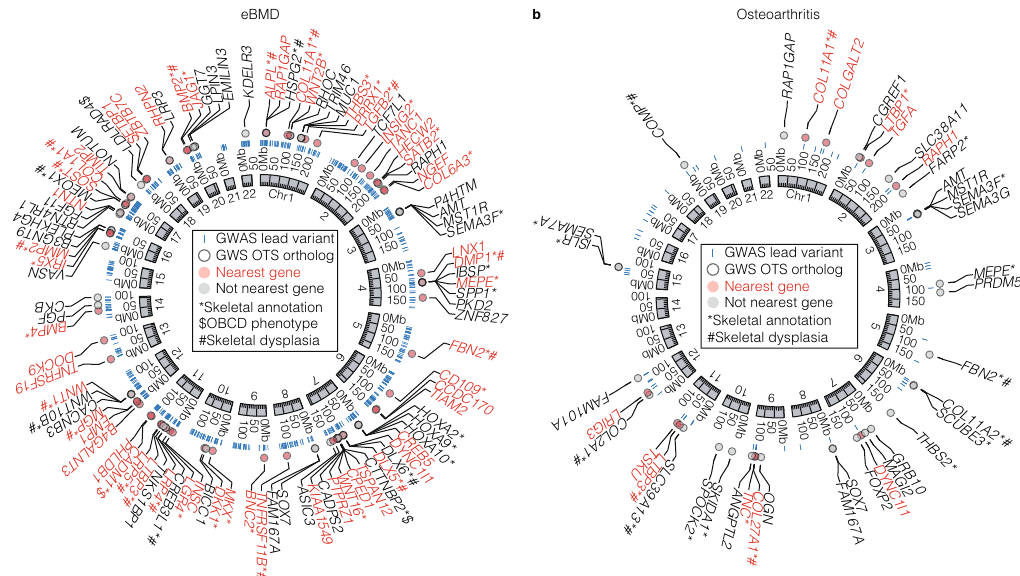
Fig. 7 Osteocyte transcriptome signature genes are associated with eBMD and osteoarthritis in humans. a The top 100 osteocyte transcriptome signature orthologs with signi fi cant gene-wise associations (GWS OTS ortholog) with eBMD 25 (ranked by P JOINT < 2 × 10 − 6 ). The genome coordinates of each human ortholog are shown. b , The 40 osteocyte transcriptome signature orthologs with signi fi cant gene-wise associations (GWS OTS ortholog) with OA (any subcategory) 64 ( P JOINT < 2 × 10 − 6 ). Blue bars show the genome coordinates of signi fi cant, conditionally independent GWAS variants associated with eBMD ( a ) or OA ( b ) (GWAS lead variants). Genes with signi fi cant gene-wise associations and that are located nearest to these loci are shown in red, genes that are not nearest to these loci are shown in black. Genes annotated with a role in the skeleton (either GO biological processes database or skeletal phenotype in the MGI database) are denoted with *, genes in the Origins of Bone and Cartilage Disease (OBCD) database are denoted with $ and genes that cause skeletal genetic disorder when mutated in humans denoted with